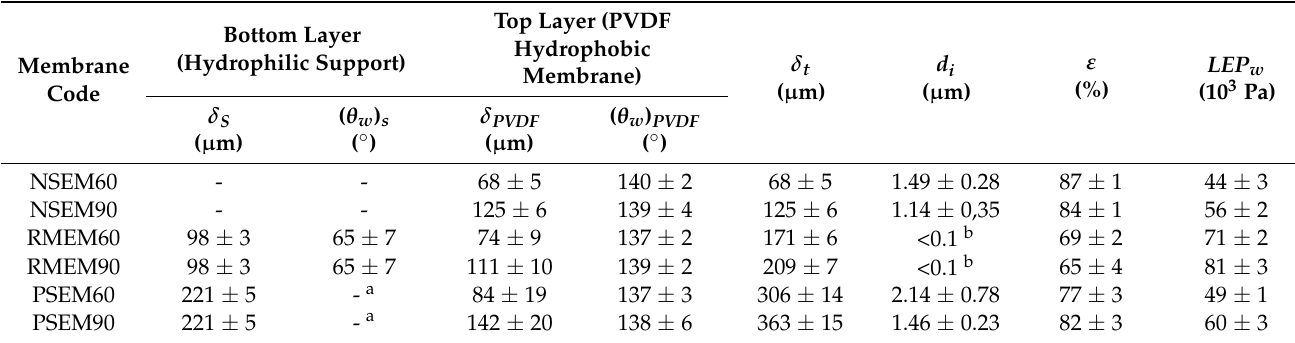
Table 3. Characteristics of the electrospun unsupported and supported nanofibrous membranes prepared with 60 and 90 min electrospinning time: Thickness ( δ ) and water contact angle ( θ w ) of the top and bottom surfaces of the